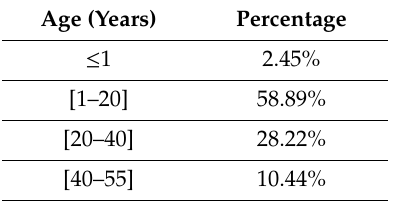
Table 3. Distribution of the age at symptom onset in patients with MEFV